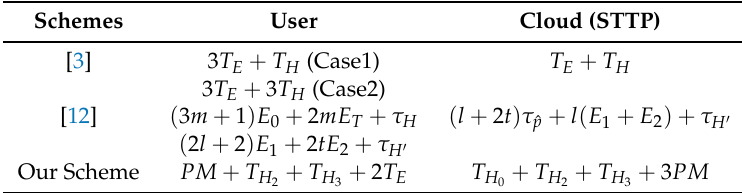
Table 6. Comparison of Computational Complexity in the Data Update